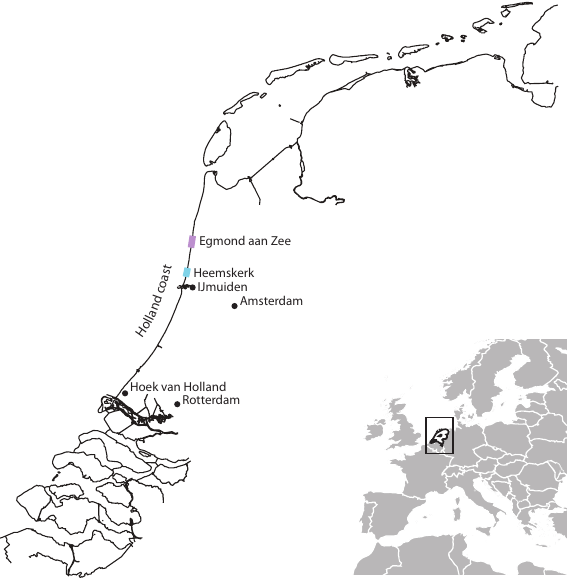
Table 1. Storm surges of the 18th century.